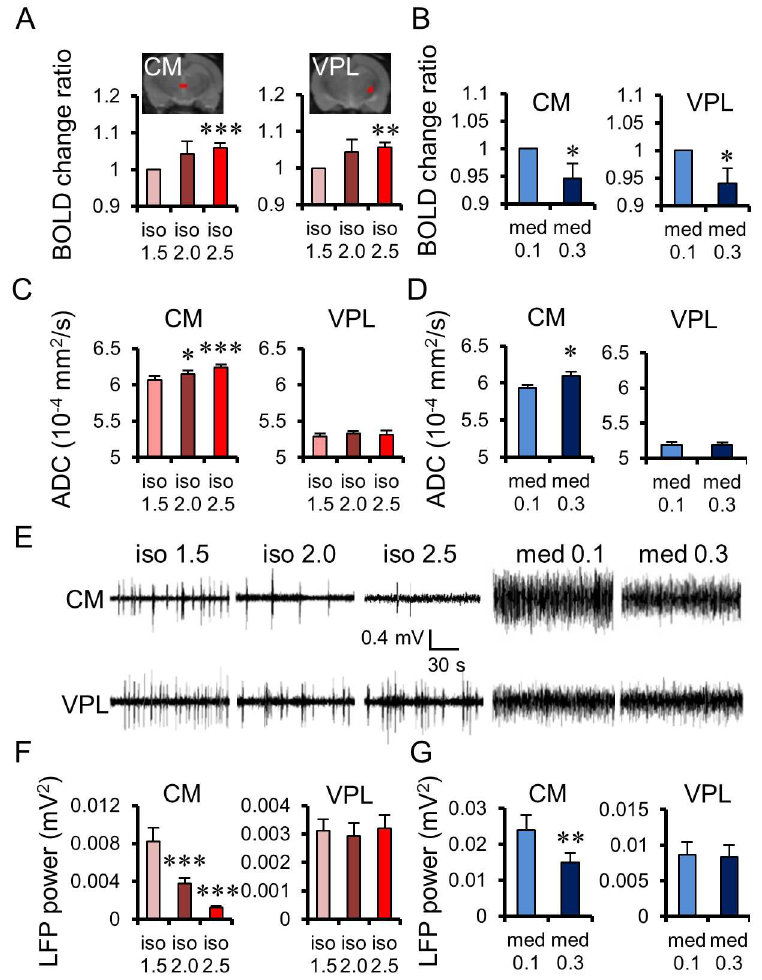
Fig 3. Comparison of Apparent Diffusion Coefficient (ADC) and Blood Oxygenation Level— Dependent (BOLD) changes with Local Field Potentials (LFPs) in the Central Medial (CM) and Ventral Posterolateral (VPL) thalamic nuclei. BOLD changesunder each dosage of isoflurane (A) and medetomidine (B) at the CM and the VPL. Region of interest (ROI) locationsfor the CM and the VPL are overlaidon structural images. ADC changesunder each dosage of isoflurane (C) and medetomidine (D) at the CM and the VPL. (E) Representative LFP signalsin a single animal at the CM (upper) and the VPL (below), for each dosage of isoflurane and medetomidine. Total LFP power (frequency range: 1–70 Hz) under each dosageof isoflurane(F; n = 8 for CM, n = 8 for VPL) and medetomidine (G; n = 8 for CM, n = 8 for VPL). Bar plots exhibit mean ± the standarderror of the mean (SEM). * p < 0.05, ** p < 0.0, *** p < 0.001 (Paired t -test, versus low dose of each anesthesia). Data for the CM and the VPL of individual rats can be found in S1 Data for ADC and S2 Data for BOLD. LFP power data for the CM and the VPL of individualrats can be found in S4